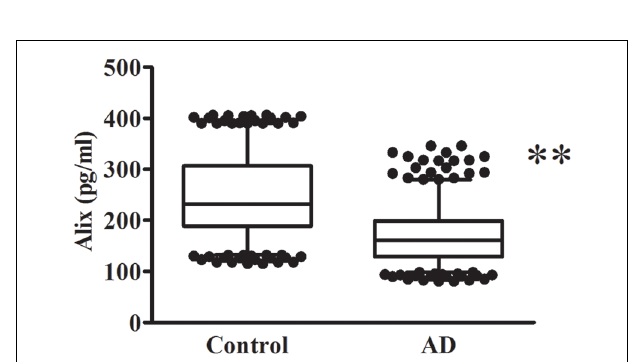
FIGURE 2 | Alix levels in serum are presented as box plots for AD patients and healthy controls. The lower and upper sides of the boxes indicate the 25th and 75th percentiles, and the horizontal lines indicate the means. The lower and upper whiskers are also shown that indicate the minimum and maximum values, respectively. n = 404 per group. ∗∗ p < 0.01 vs. the control group, Student’s t